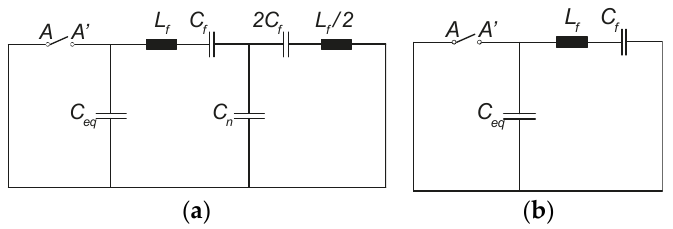
Figure 9. Circuit diagrams for three-phase filter current interruption: ( a ) one phase interruption and ( b ) all three-phase interruption.